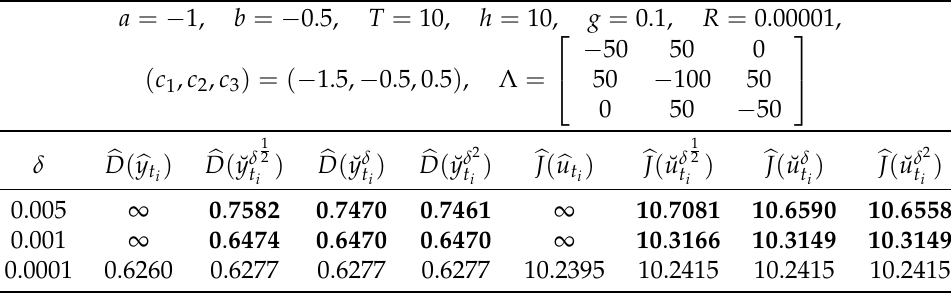
Table 5. The results with transition intensities